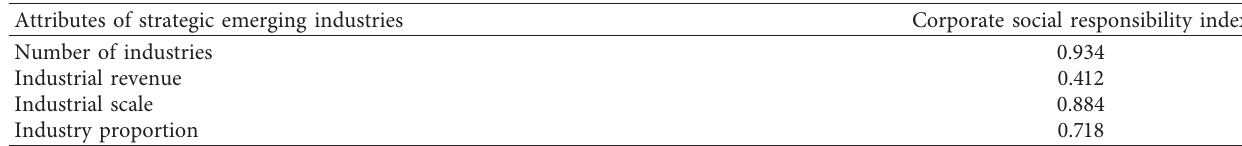
Table 1: Correlation coefficient between the development of strategic emerging industries and university students’ innovative undertaking. Attributes of strategic emerging